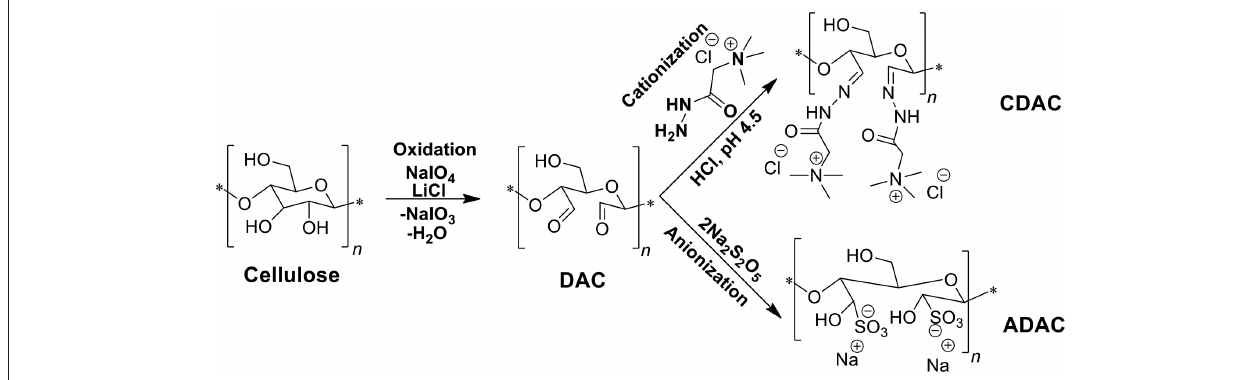
FIGURE 1 | Production of positively and negatively charged cellulose-based PELs, by periodate oxidation (DAC) followed by cationization of DAC with Girard’s reagent T (CDAC) or anionization with sodium metabisulfite (ADAC).